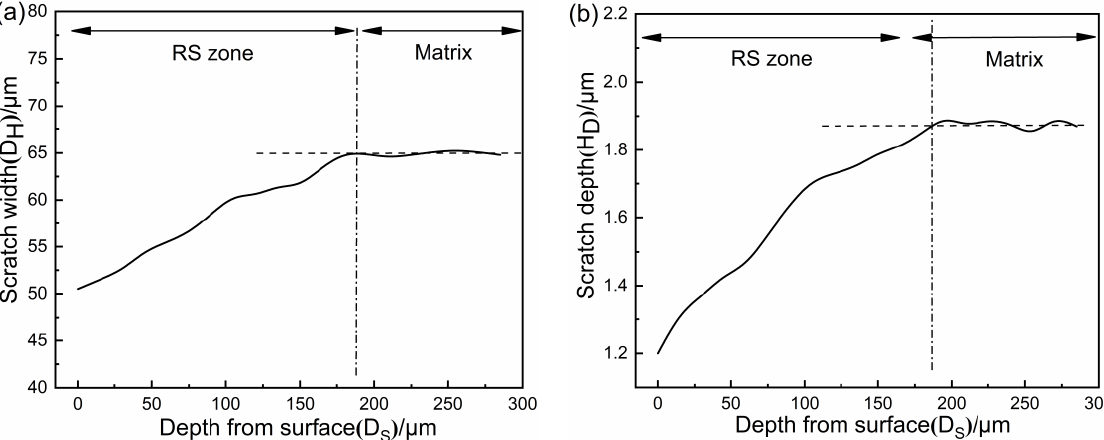
Figure 12. Curves of ( a ) scratch width and ( b ) scratch depth with depth from the surface.